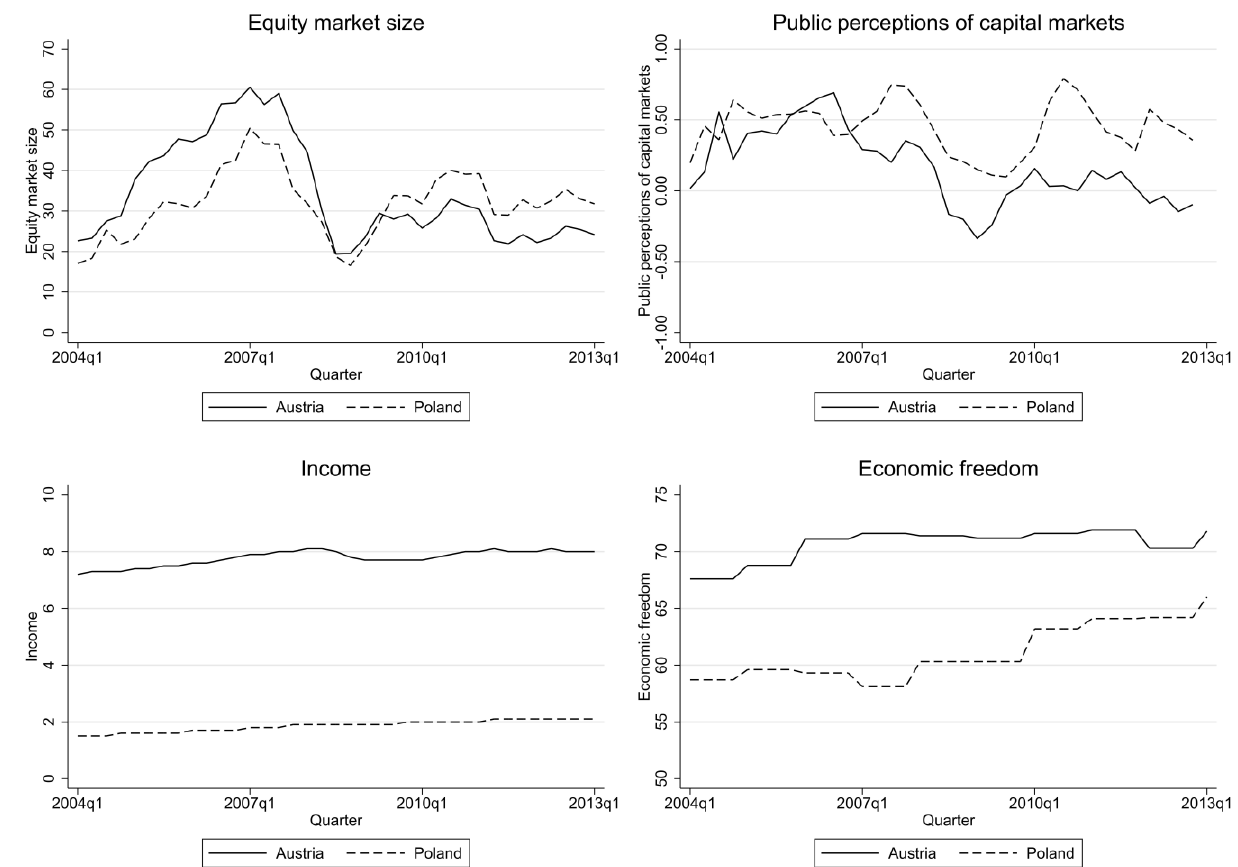
Figure 1. Comparative time series graphs of main regression variables. Data sources: Equity market size (equity market capitalization as a share of real GDP per year) and Income (real GDP per capita in constant EUR thousandth) are taken from the Eurostat database, economic freedom is measured by the Heritage Foundation’s Index of Economic Freedom, and Public perception of capital markets is measured through Janis – Fadner coefficients of coded newspaper articles from the Factiva database.